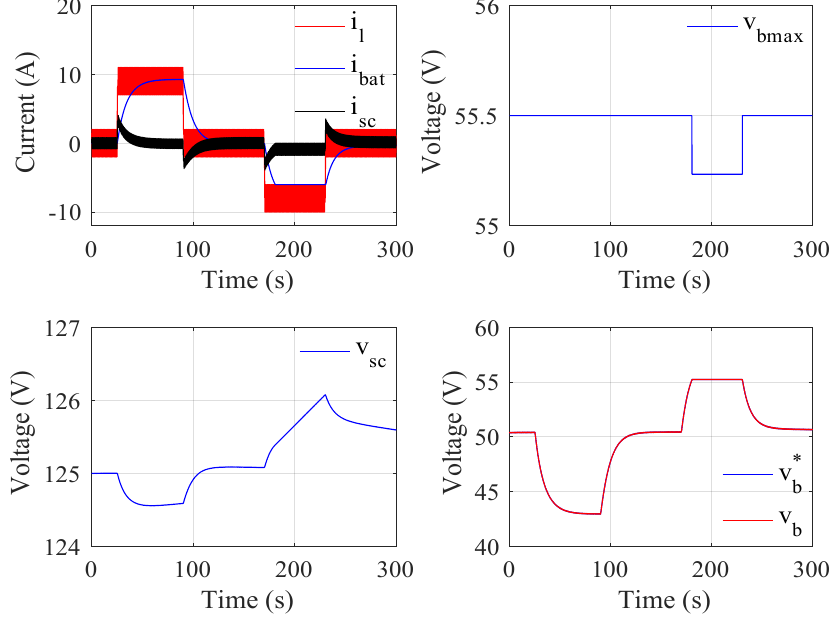
Figure 6. Simulation results, in charge